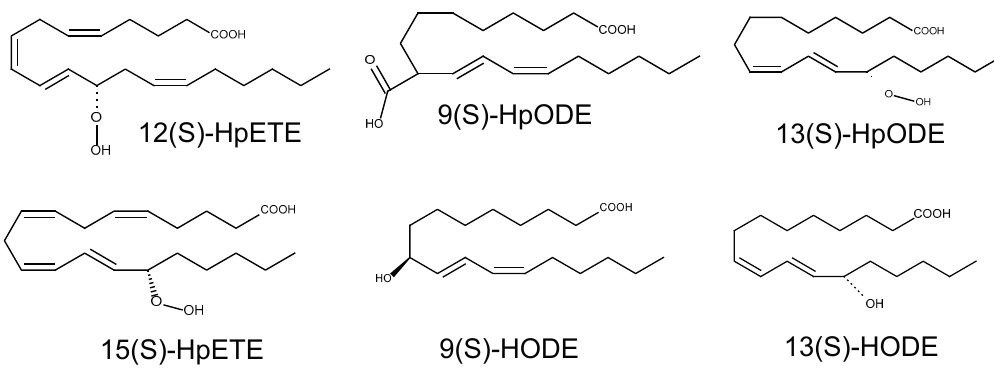
Figure 3. Lipid hydroperoxides (LOX